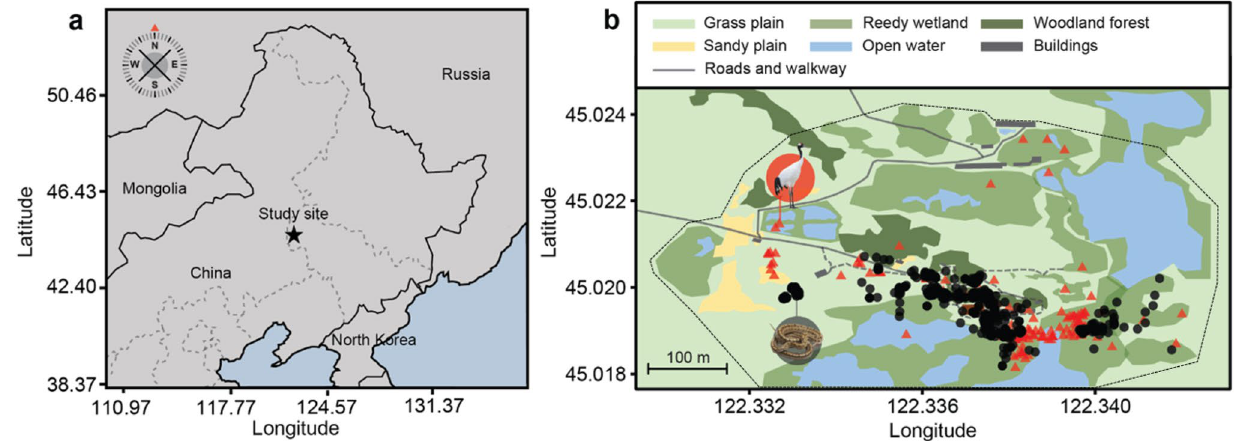
Figure 1. ( a ) Location of the study site at the Red-Crown Crane Park at the Xianghai Natural Reserve in Jilin province, China. ( b ) Individual GPS points of all individual Elaphe dione radio tracked (black circles) and their avian predator, Grus japonensis sightings (red triangles) during the summer period (May–July). Black dotted line around crane park presented the boundary between Red-Crown Crane Park and the Xianghai Natural Reserve. This figure was generated by using R (R × 64 3.1.3) 70